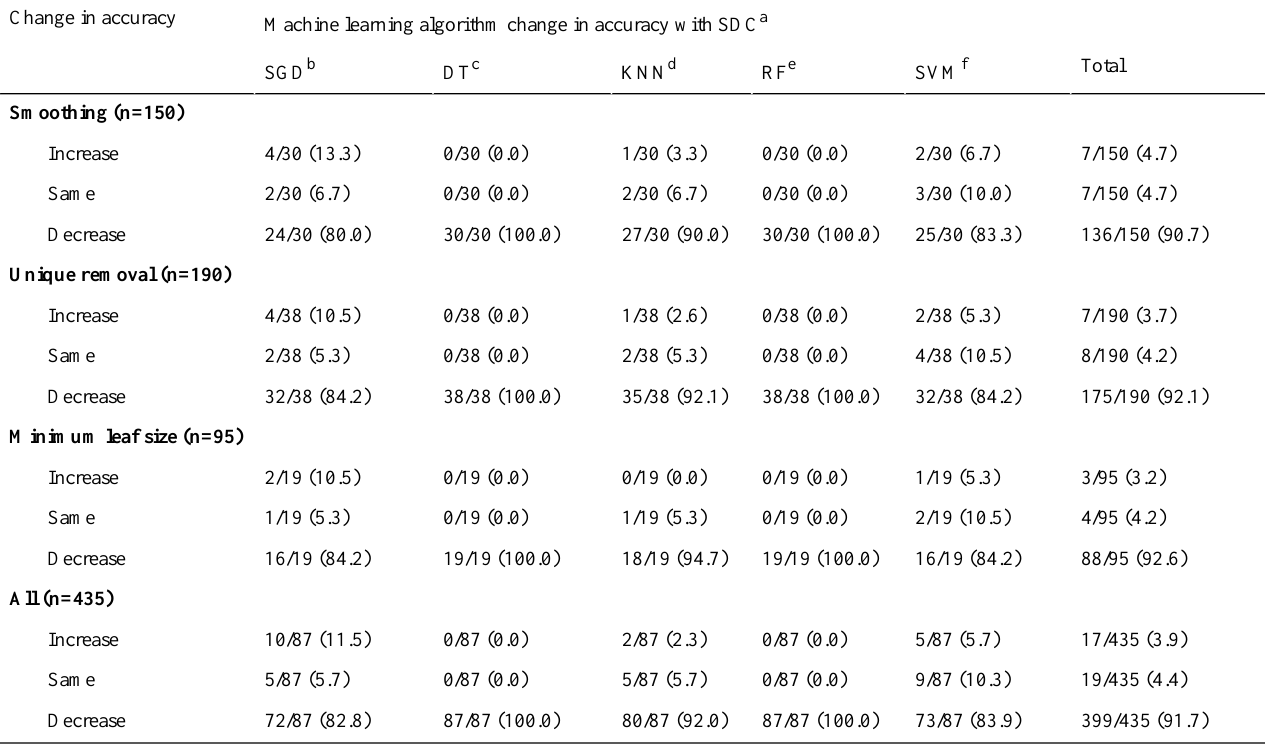
Table 7. Changes in accuracy for each machine learning model and with statistical disclosure control applied. Machine learning algorithm change in accuracy with SDC a Change in